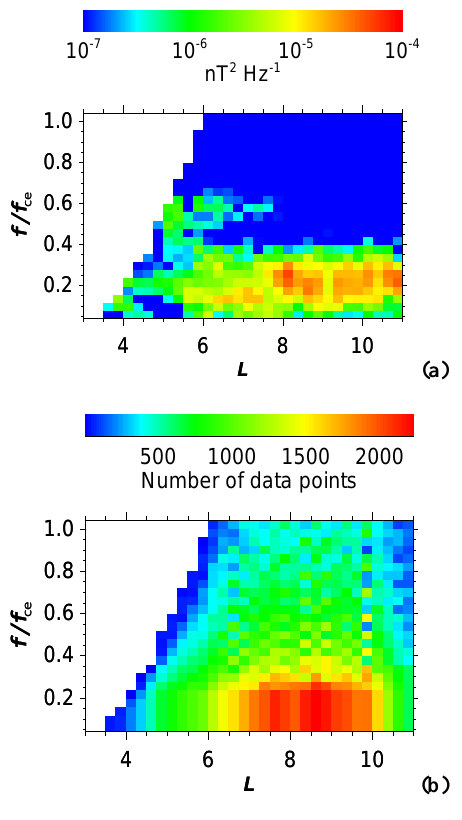
Fig. 3. (a) Average power-spectral density spectrogram as a func- tion of McIlwain’s L parameter and the wave frequency f normal- ized by the local f ce . 42000 individual spectra recorded during the orbits from Fig. 2 have been accumulated. (b) Number of power- spectral density points used in each bin of Fig. 3a.